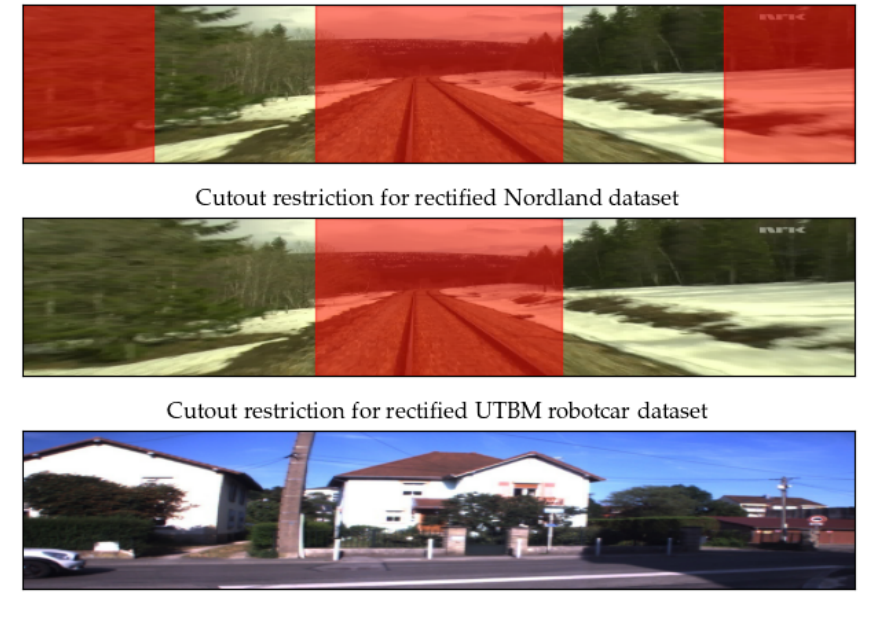
Figure 5. For individual datasets, different restrictions of candidate cutout regions have been used. The coarse dataset is designed to focus on distant objects, in the rectified dataset, we only limit the network from learning to align using the rails, and the EU long-term dataset is used as